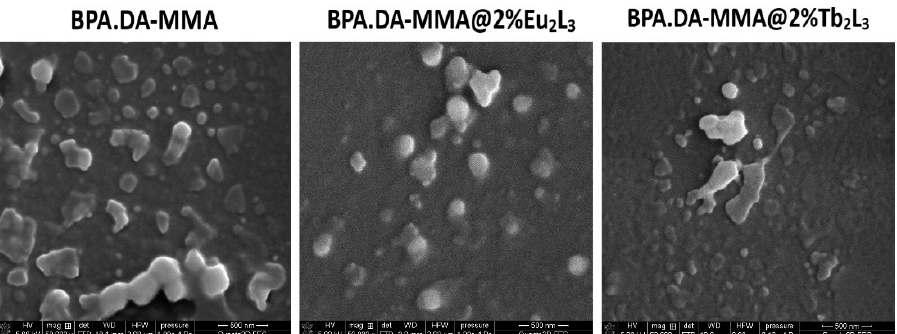
Figure 2. Optical microscope images: ( a ) BPA.DA-MMA; ( b ) BPA.DA-MMA@0.1%Eu 2 L 3 ; ( c ) BPA.DA-